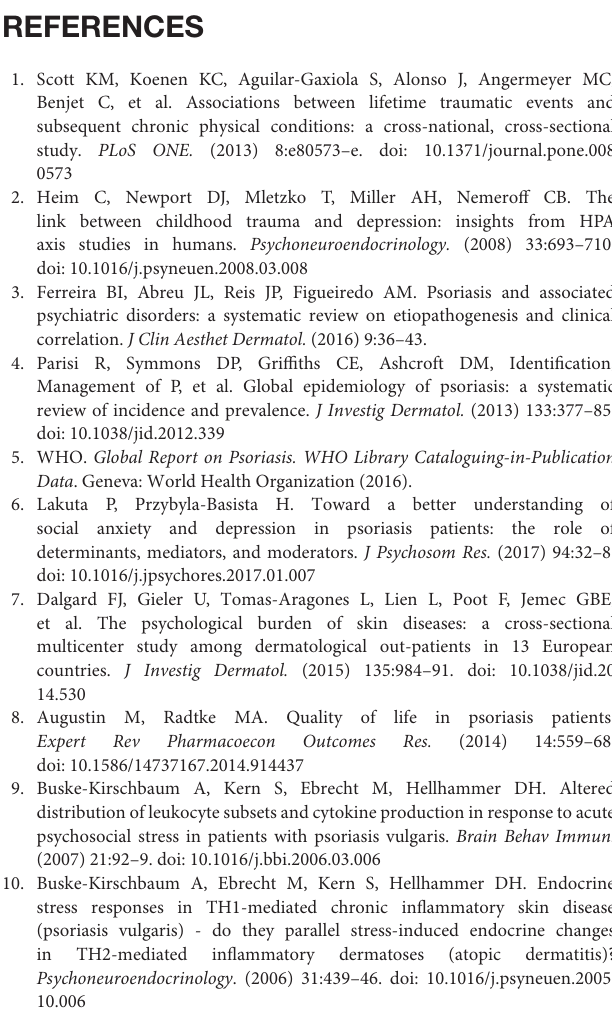
Supplementary Table S4a | Results of the hierarchical regression analysis to assess the effect of the variables age, gender, SAPASI (T1) (step 1), PSS ‘perceived stress’ at T1 (step 2) and the interaction SAPASI (T1) × PSS ‘perceived stress’ (step 3) on the treatment outcome (Delta SAPASI). Sample size: n = 52 patients with complete data. Bold values indicate significance at p ≤ 0.05. Supplementary Table S4b | Results of the hierarchical regression analysis to assess the effect of the variables age, gender, SAPASI (T1) (step 1), CTQ total at T1 (step 2) and the interaction SAPASI (T1) × CTQ total (step 3) on the treatment outcome (Delta SAPASI). Sample size: n = 58 patients with complete data. Bold values indicate significance at p ≤ 0.05. Supplementary Table S5 | Results of the moderator analysis according to the Macro Modell Process by Hayes, using multiple imputation for missing data . Delta SAPASI was included as independent variable. Treatment outcome (Delta DLQI) as dependent variable. Age and gender, were included as covariates, PSS ‘perceived stress’ at T1 and CTQ total as moderators. Sample size: n = 83 patients. Bold values indicate significance at p ≤ 0.05. Supplementary Table S6 | Results of the moderator analysis according to the Macro Modell Process by Hayes, using multiple imputation for missing data . SAPASI at T1 was included as independent variable. Treatment outcome (Delta SAPASI) as dependent variable. Age and gender were included as covariates, PSS ‘perceived stress’ at T1 and CTQ total as moderators. Sample size: n = 83 patients. Bold values indicate significance at p ≤